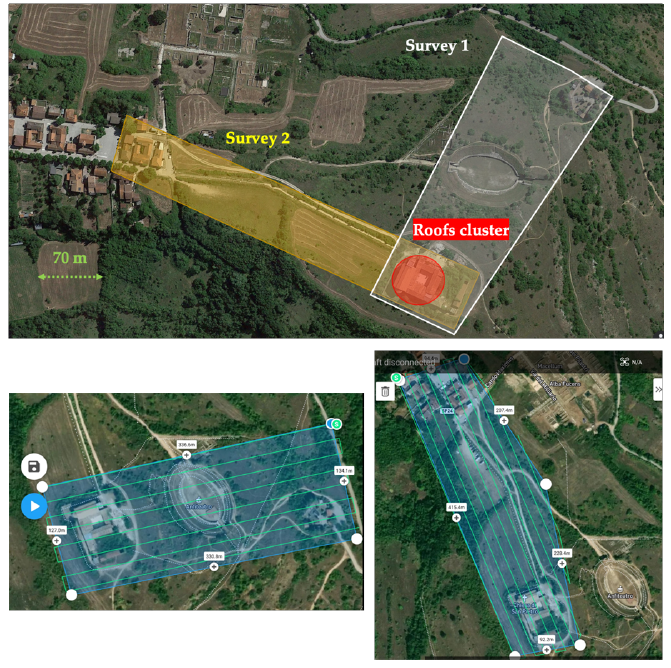
Figure 6. Overview of Alba Fucens and area covered by the two surveys and the flight plans of S1 and S2.